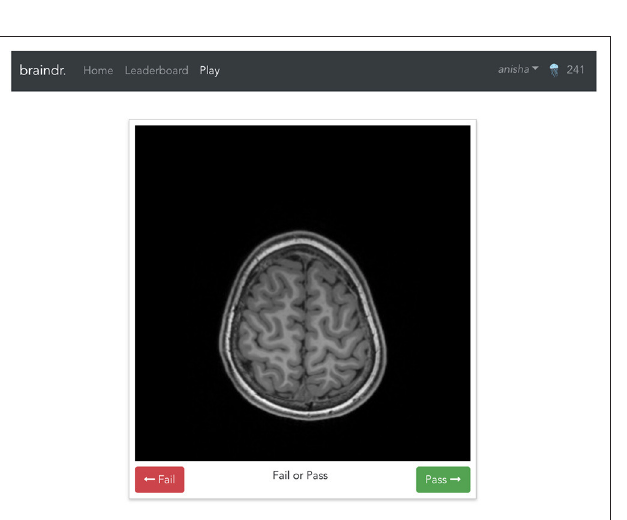
FIGURE 6 | The braindr web interface: Braindr was hosted at https://braindr. us. Users may click pass or fail buttons, use arrow keys, or swipe on a touchscreen device to rate the image. The top right shows the user’s